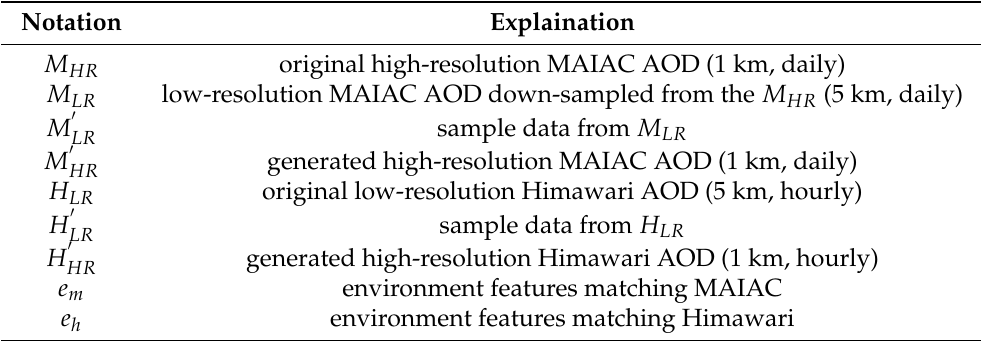
Table 1. The notations in the following sections and Figure 1.